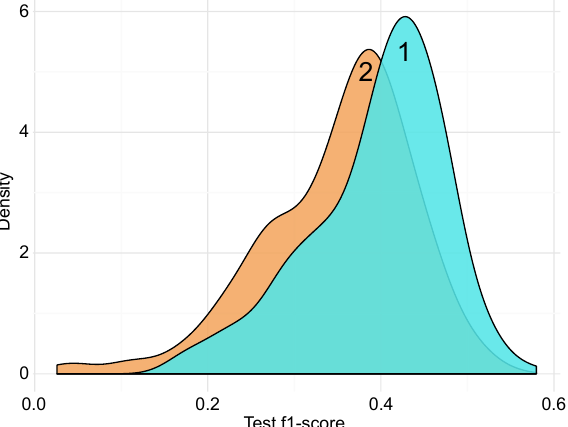
Figure 5. Side-by-side comparison between phase 2 experiment results with (1) and without (2) regression post-processing. Post-processing consisted of discarding predicted points within patches where regression output (i.e., predicted number of seals in patch) is smaller than a specified threshold. For each model, we explore a range of thresholds to obtain the maximum possible test f1-score obtained after post-processing, using the same optimal threshold across the entire expert-selected test set.